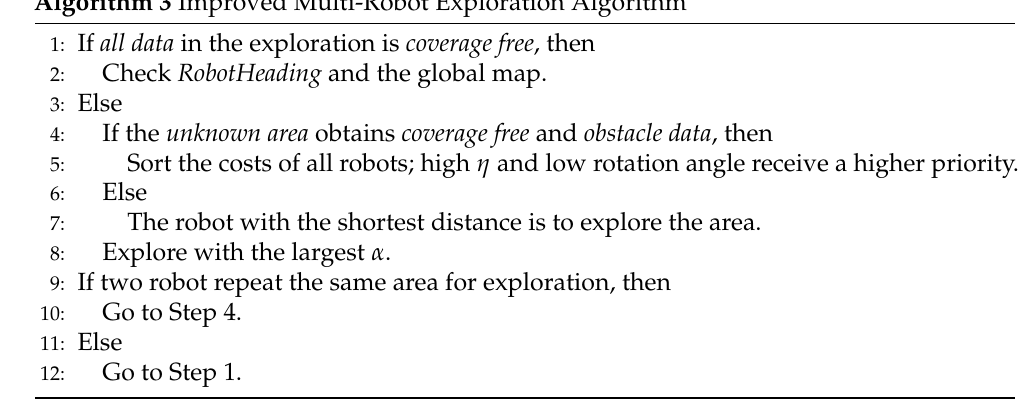
Algorithm 3 Improved Multi-Robot Exploration Algorithm